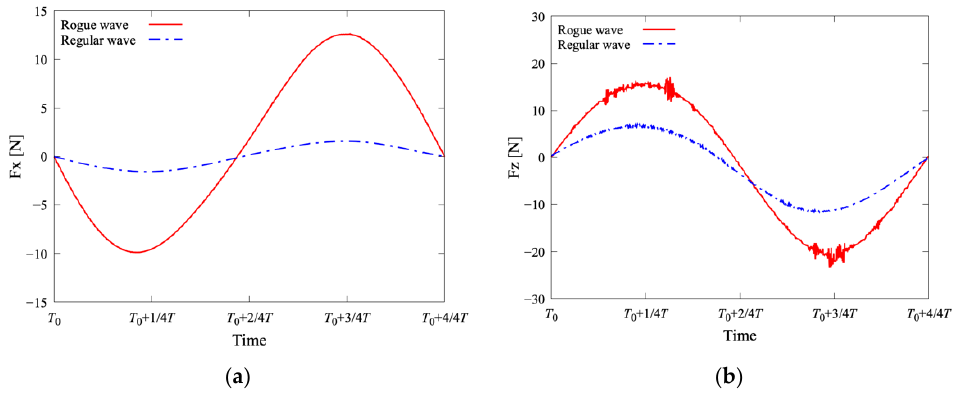
Figure 19. Forces on a floating body: ( a ) x-force; ( b ) z-force.